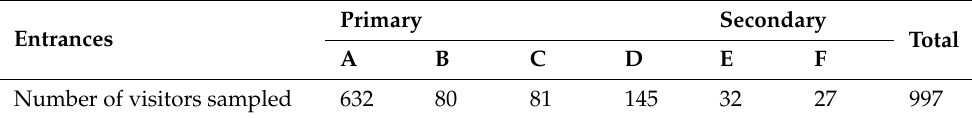
Table 2. The pattern of the visitors sampled.